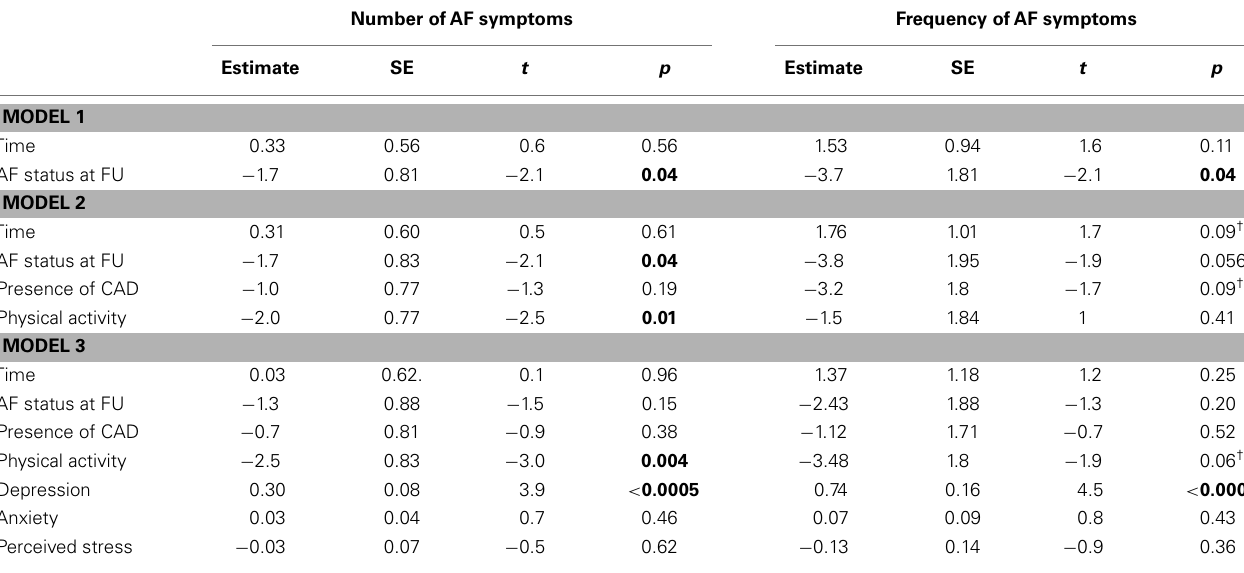
Table 6 |Associates of change in the reported number and frequency ofAF symptoms before and after ECV. Number ofAF